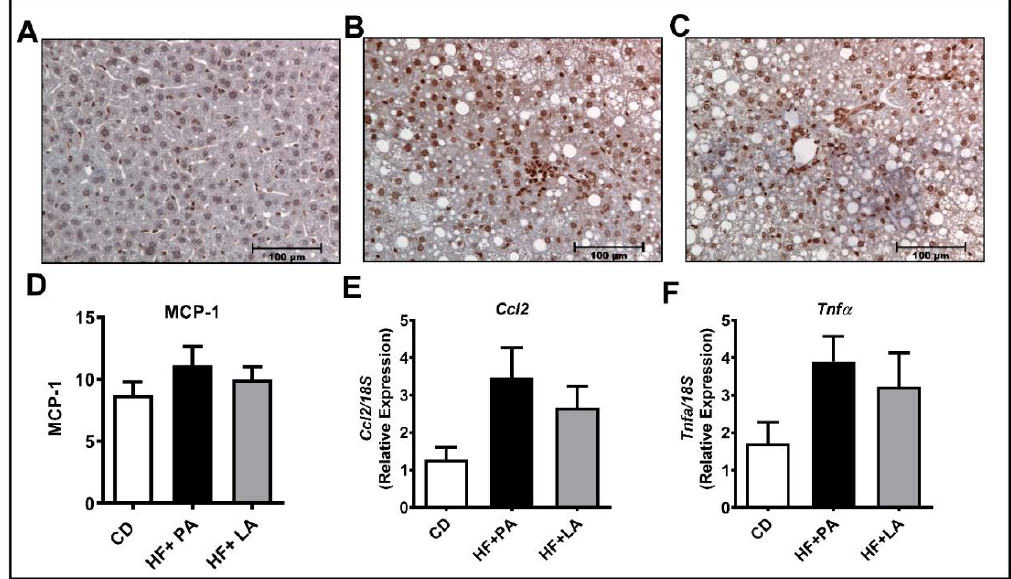
Figure 8. Effect of HF diet supplemented with PA or LA on markers of hepatic inflammation. Immunohistochemical analysis was performed to detect MCP-1 in liver sections from CD ( A ), HF + PA ( B ), and HF + LA-fed mice ( C ). Representative images at 20 × magnification are shown. The intensity of MCP-1 staining was quantified ( D ). Quantitative real-time PCR was performed for the mRNA levels of inflammatory genes such as Ccl2 and Tnf α ( E , F ). Values are expressed as mean ± SEM of 6–8 samples in each group. MCP-1, monocyte chemoattractant protein-1; Ccl2 , C-C chemokine ligand 2; Tnf α , Tumor necrosis factor α ; CD, chow diet; HF + PA, high fat + palmitic acid; HF + LA, high fat + lauric acid.